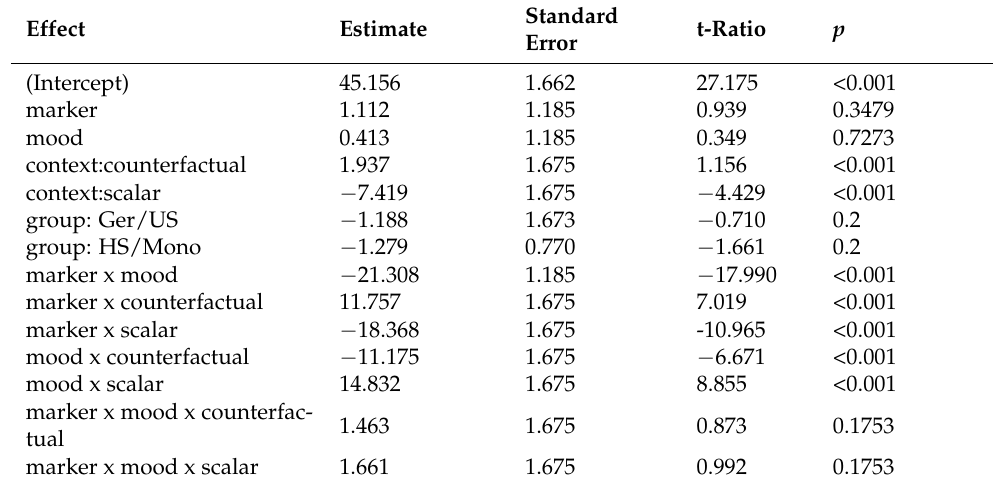
Table 8. Regression table to predict responses for sentence